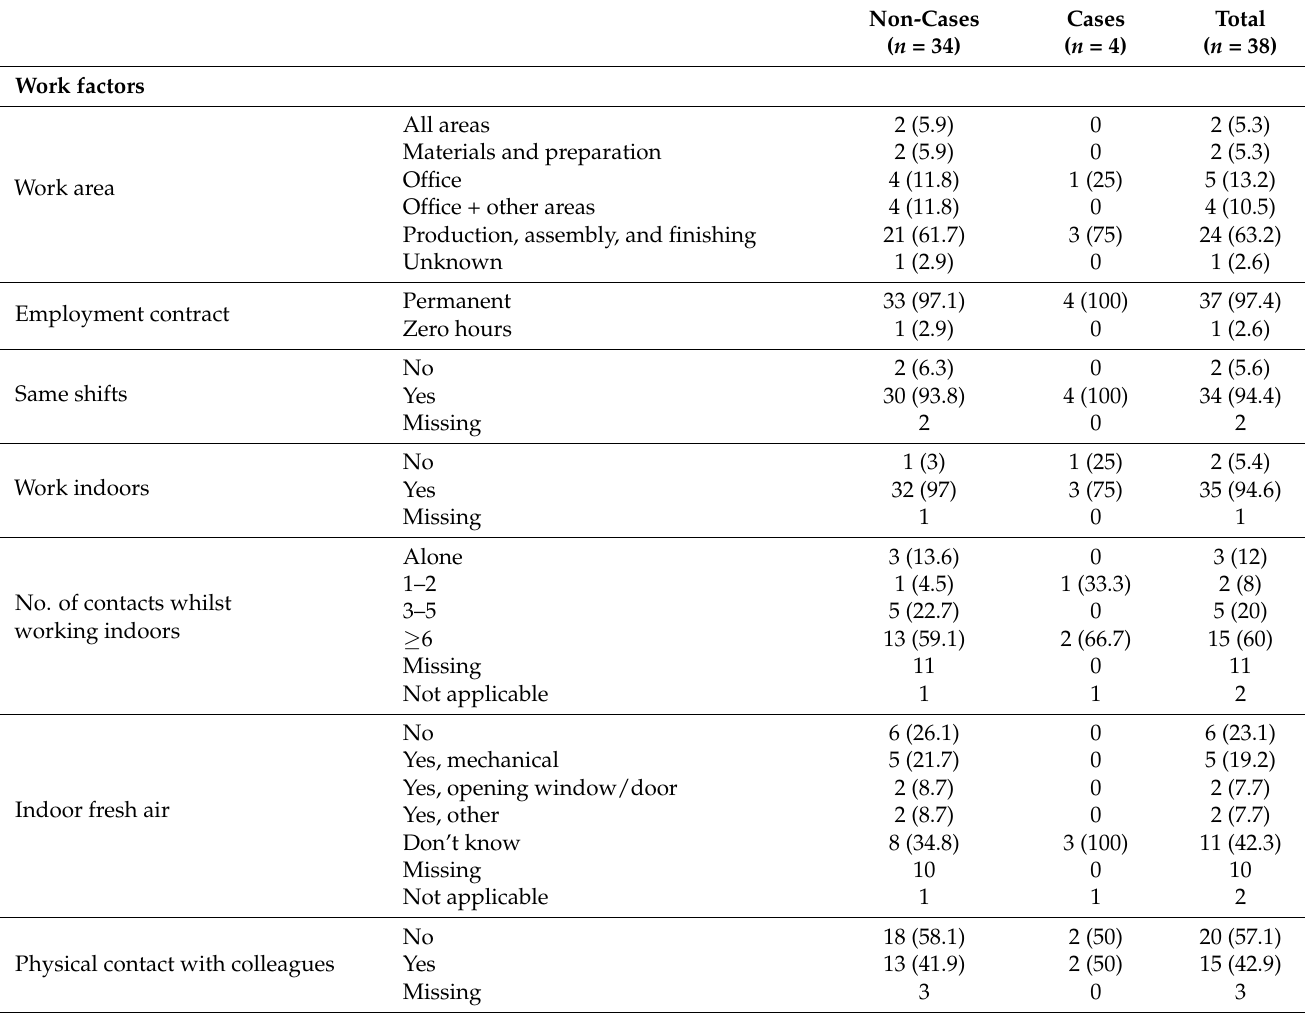
Table 1. Participant work factors and COVID-19 prevention related responses to baseline COVID- OUT study